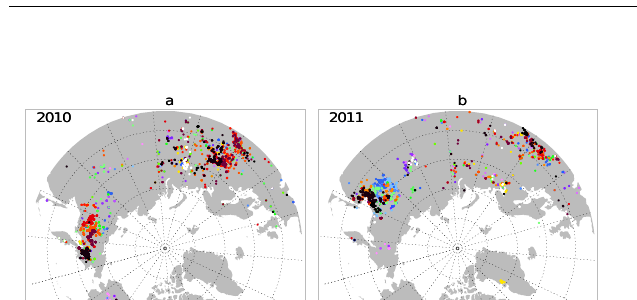
Quebec to Greenland and Iceland. Figure 5d shows that the 2010 flow was similar to the climatological pattern with only weak positive anomalies in height over North America and stronger positive anomalies with ridging off the west coast of Canada and over European Russia and far eastern Siberia and Kamchatka. This is in contrast to the BORTAS-B period in Fig. 5g, with strong positive anomalies in geopotential height over the upper Mississippi, the North Pacific and a dra- matic positive height anomaly over eastern Siberia. A pos- itive anomaly also lies over the mid-North Atlantic, cover- ing all of Greenland, possibly resulting in a more northerly route for the North Atlantic transport to the European con- tinent. Labrador and Maritime Canada had negative anoma- lies along with Alaska and British Columbia. The Maritime Canada negative anomaly is indicative of the cooler and cloudy weather that occurred during